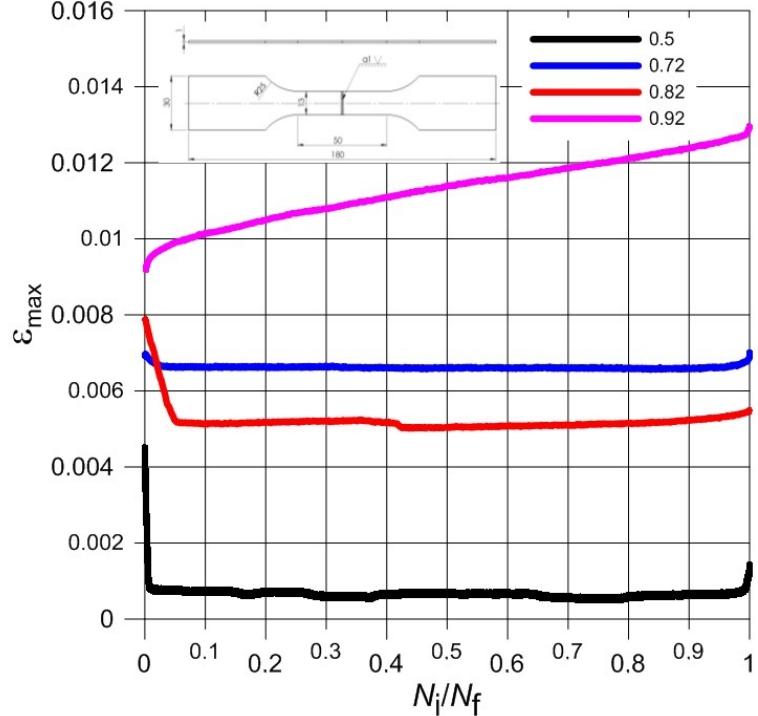
Figure 6. The course of maximum total strain during the fatigue load process of Type 2 samples.